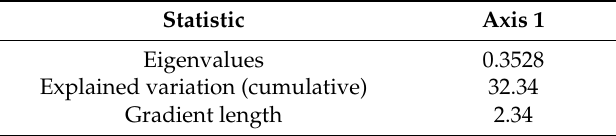
Table 1. Detrended correspondence analysis results for the homogeneity of variables.